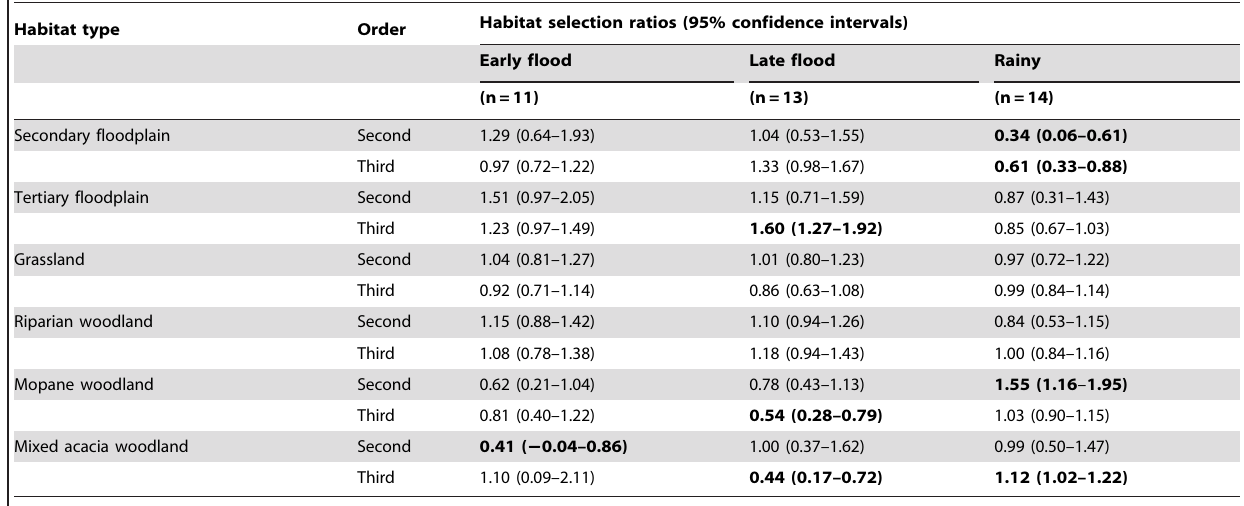
Table 4. Seasonal second and third order habitat selection ratios and confidence intervals.